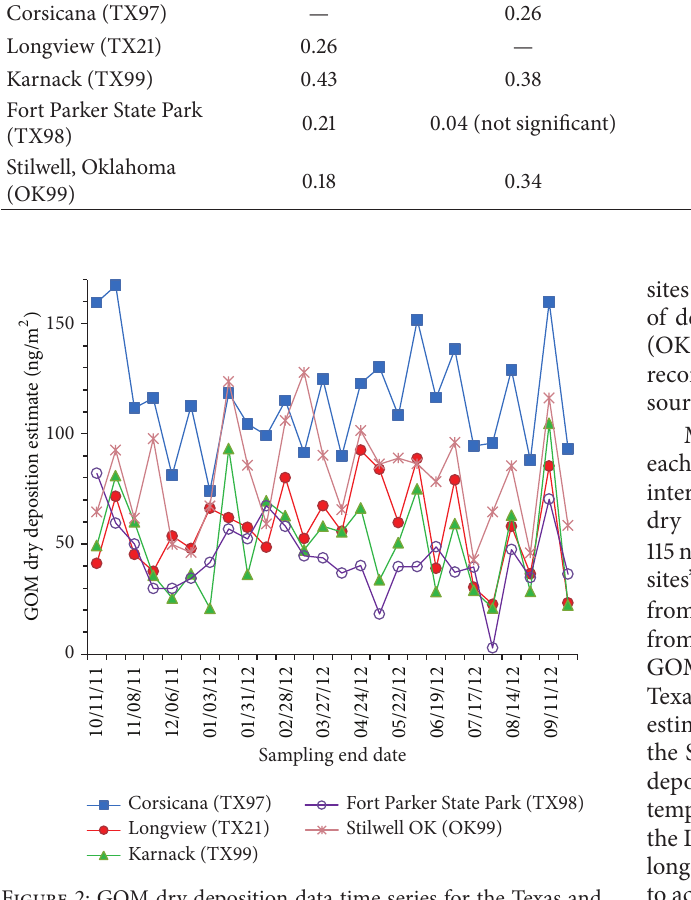
Figure 2: GOM dry deposition data time series for the Texas and Stilwell, Oklahoma sites; September 27, 2011, to September 25,